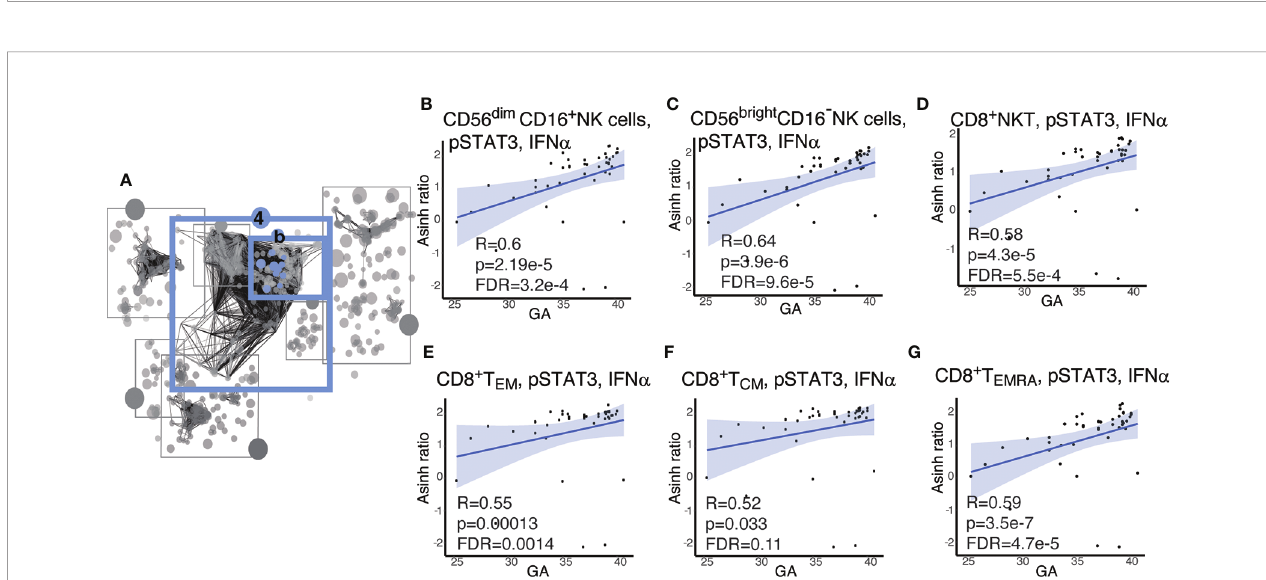
FIGURE 6 | Cytotoxic cells exhibit increasing pSTAT3 response to IFN a with advancing GA. (A) Community 4b contains information on 67 immune features corresponding to the response of the STAT pathway to IFN a . (B – G) Highlighted immune features in community 4b show increasing responsiveness of pSTAT-3 in cytotoxic cells in response to IFN a . Spearman correlations.